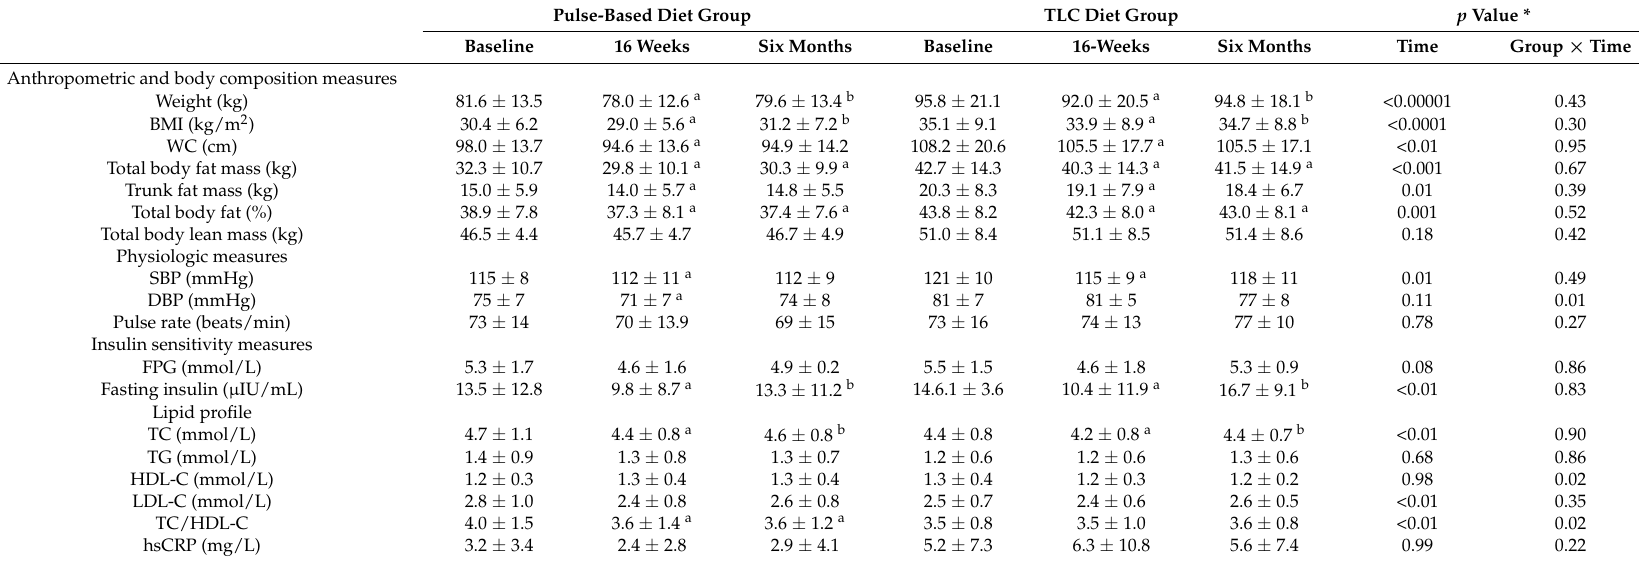
Table 4. Cardio-metabolic outcomes of women who completed the six-month follow up phase of the study at baseline, 16 weeks, and six months post-intervention. Pulse-Based Diet Group TLC Diet Group p Value * Baseline 16 Weeks Six Months Baseline 16-Weeks Six Months Time Group × Time Anthropometric and body composition measures Weight (kg) 81.6 ±